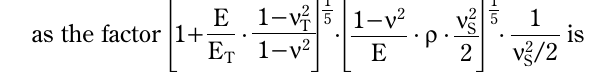
[15]rotor target